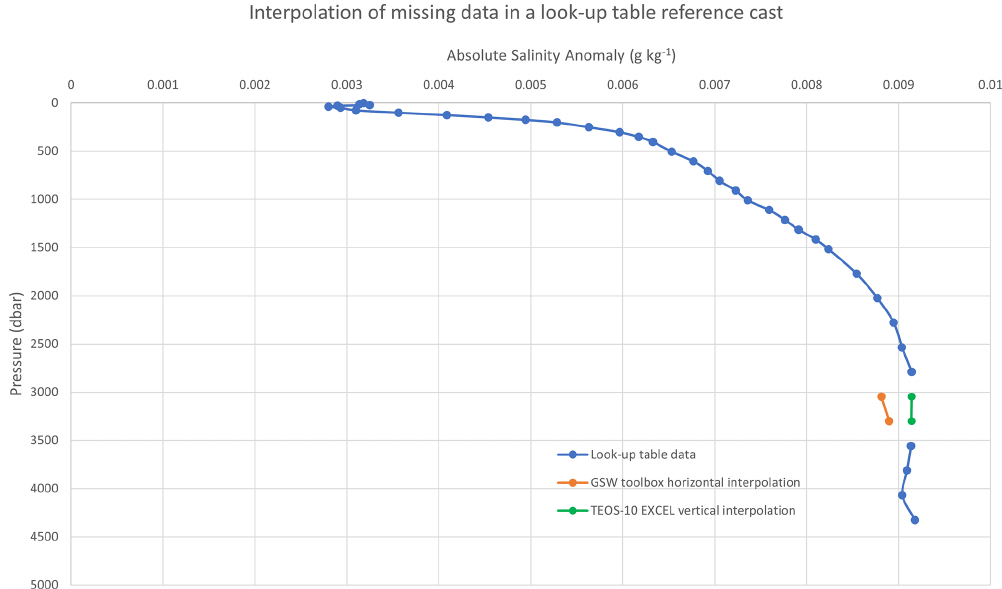
Figure 9. The δS atlas plot from [deltaSA_ref], column 8. Missing data at levels 33 and 34 (3045 and 3300dbar) are not well resolved by A horizontal interpolation (GSW toolbox). Vertical interpolation implemented in TEOS-10 Excel resolves these situations